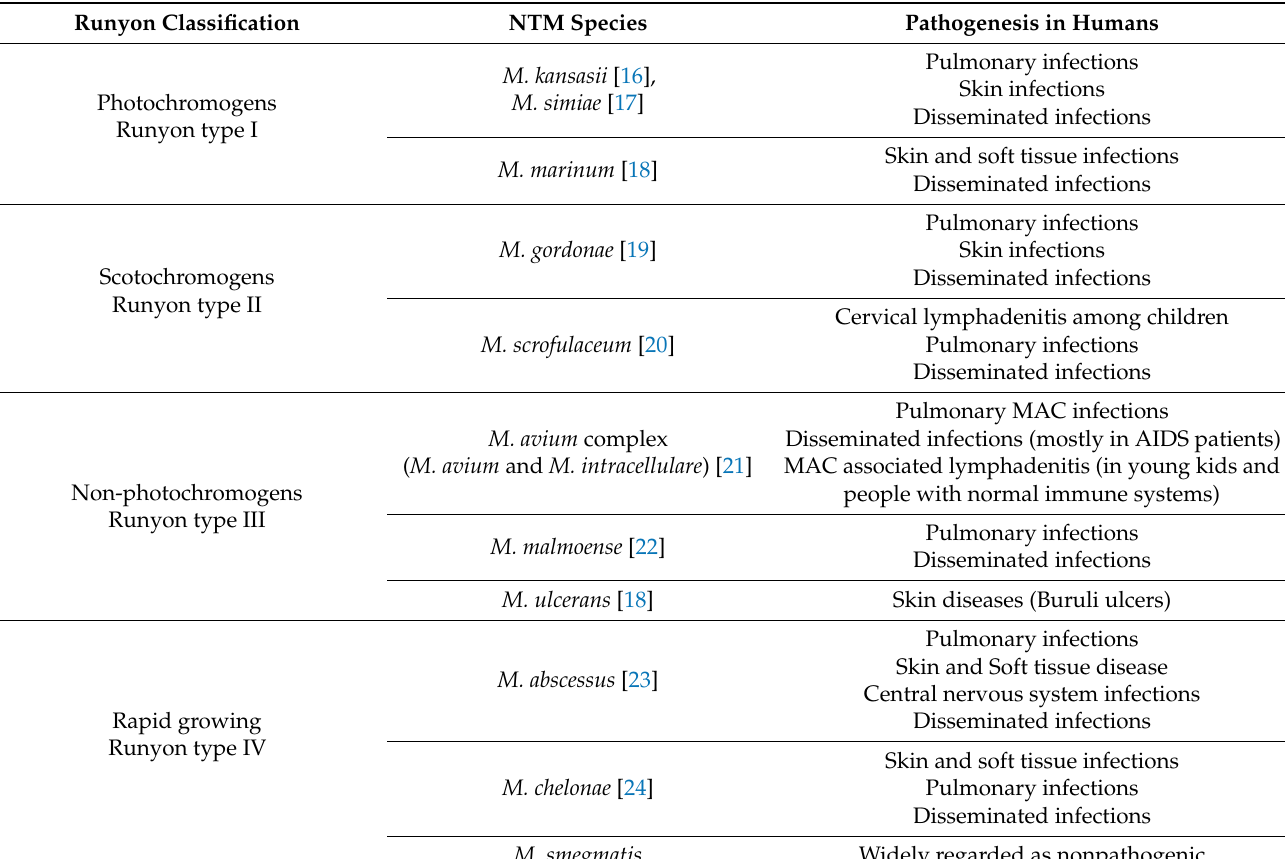
Table 1. Summary of the nontuberculous mycobacteria (NTMs) mentioned in this review, their classification according to Runyon, and their reported pathogenesis in